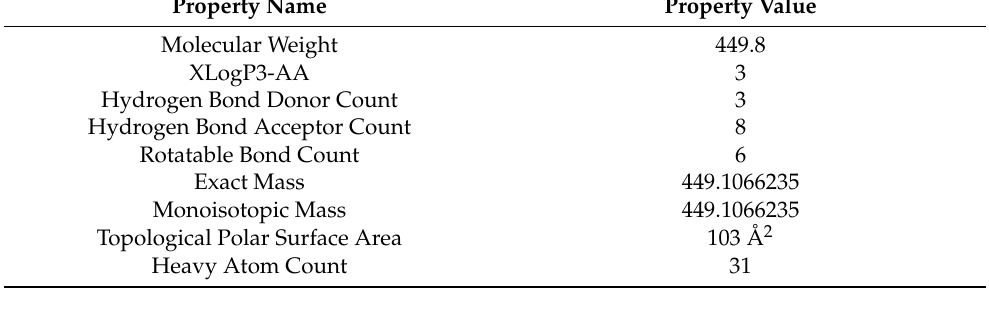
Table 3. The physiochemical properties of asciminib retrieved from Pubchem as shown in the Table.